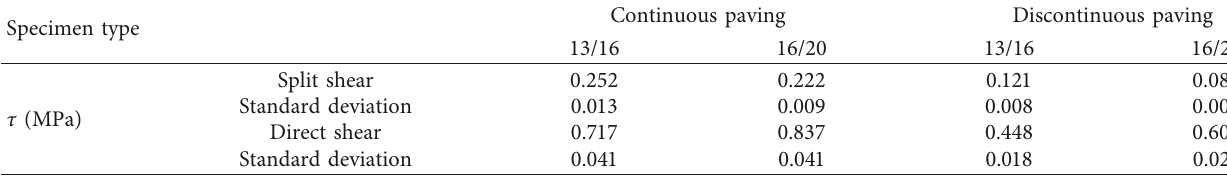
Table 6: Results of shear test at room